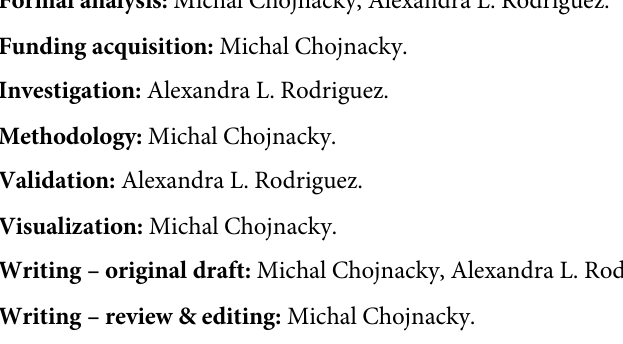
S4 Table. Standalone refrigerator repeated door opening. D T data shown in Fig 5R. “Pos error” and “neg error” show the extreme values recorded by all sensors, corresponding to the overall range. S5 Table. Combination refrigerator/freezer door left open. Average duration of viable vac- cine storage time with refrigerator door left open. S6 Table. Standalone refrigerator door left open. Average duration of viable vaccine storage time with refrigerator door left open. S7 Table. Combination refrigerator/freezer power outage. Average duration of viable vac- cine storage time, as shown in Fig 6L. “Pos error” and “neg error” show the extreme values recorded by all sensors, corresponding to the overall range. S8 Table. Standalone refrigerator power outage. Average duration of viable vaccine storage time, as shown in Fig 6R. “Pos error” and “neg error” show the extreme values recorded by all sensors, corresponding to the overall